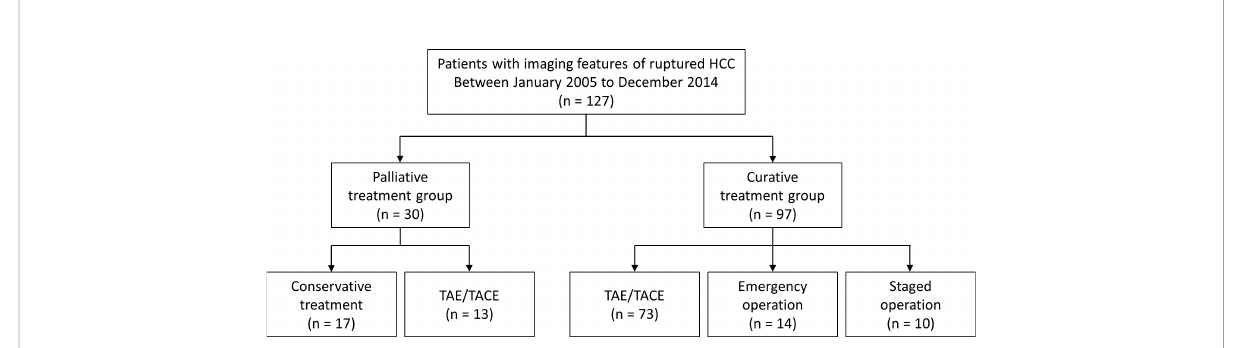
FIGURE 1 Flow chart of the study population. HCC, hepatocellular carcinoma; TAE, transcatheter arterial embolization; TACEm transcatheter arterial